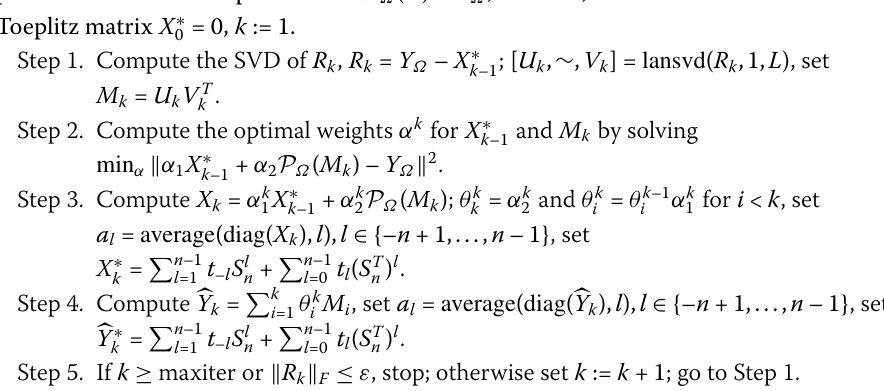
Algorithm 2.3 ([29] (Optimal low-rank matrix approximation (OLRMA) algorithm for solving problem (1.1) or (1.2))) Given an initial Toeplitz matrix P Ω ( D ), Y 1 = P Ω ( D ),